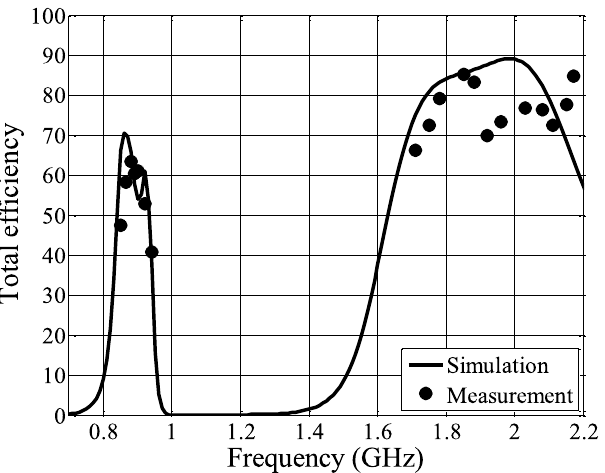
Fig. 13. Simulated and measured total ef fi ciency of dual ZOR antenna with BSF.